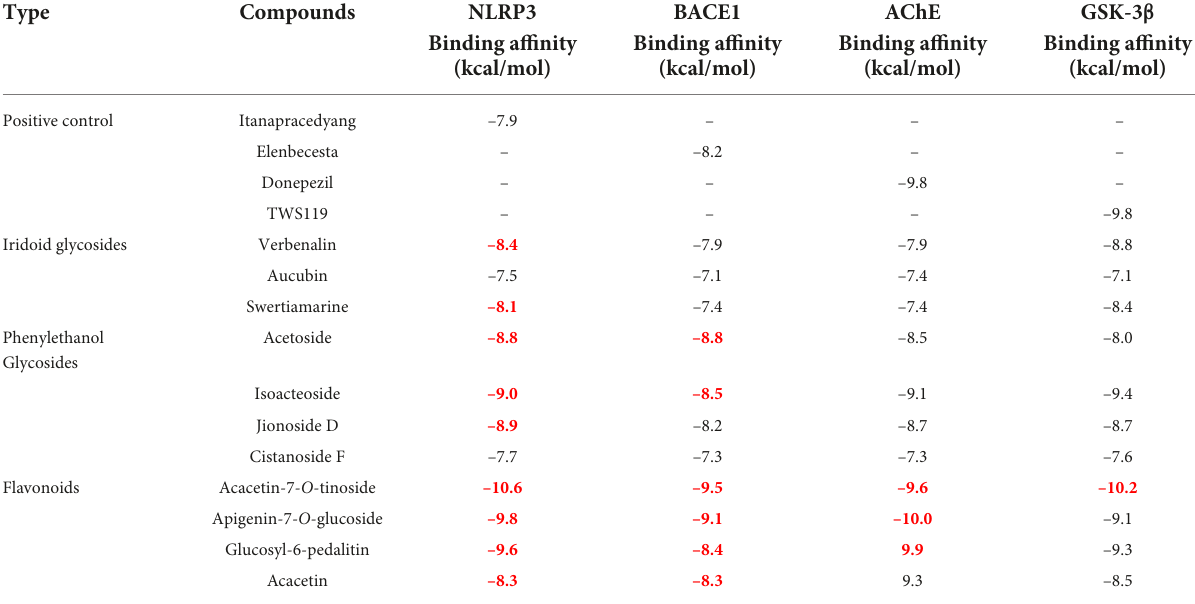
TABLE 2 Docking results of Verbena officinalis . compounds with AD target protein